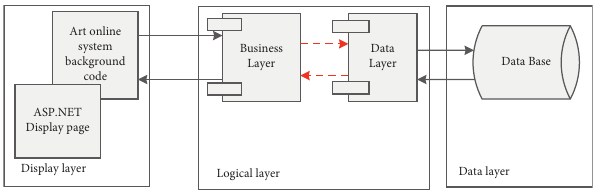
Figure 5: B/S pattern design model.